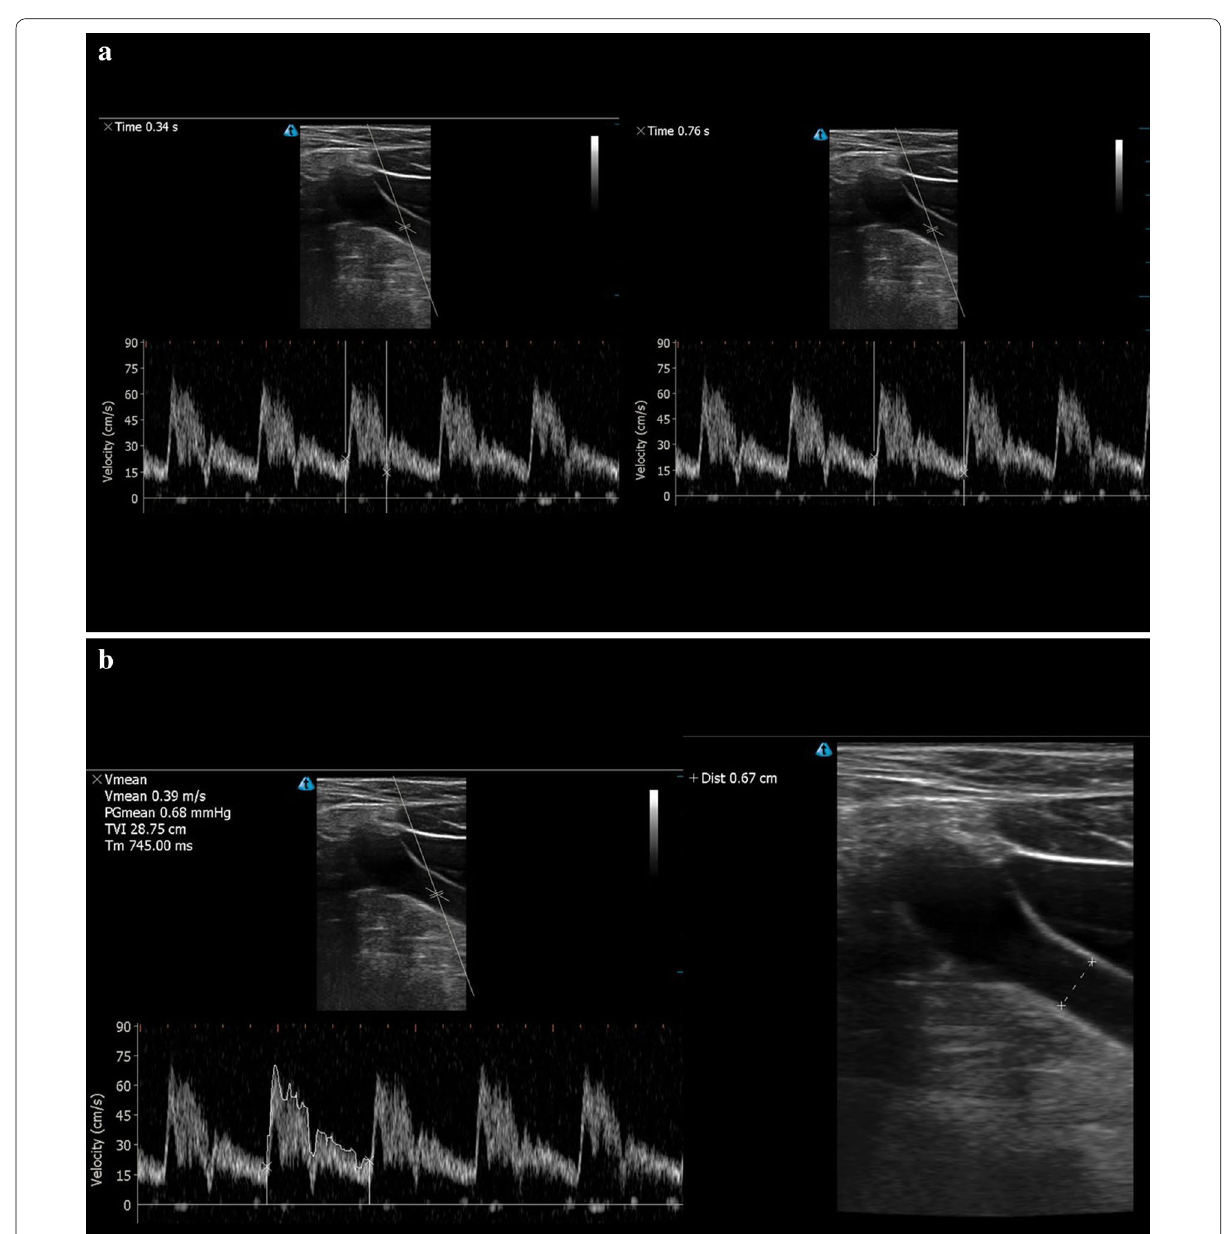
Fig. 1 a Carotid systole time, as measured from the start of the systolic upstroke to the start of the dicrotic notch ( left ). Carotid cycle time, as measured from start of one systolic upstroke to the next ( right ). b Velocity time integral tracing of the spectral Doppler signal ( left ). Carotid diameter ( right